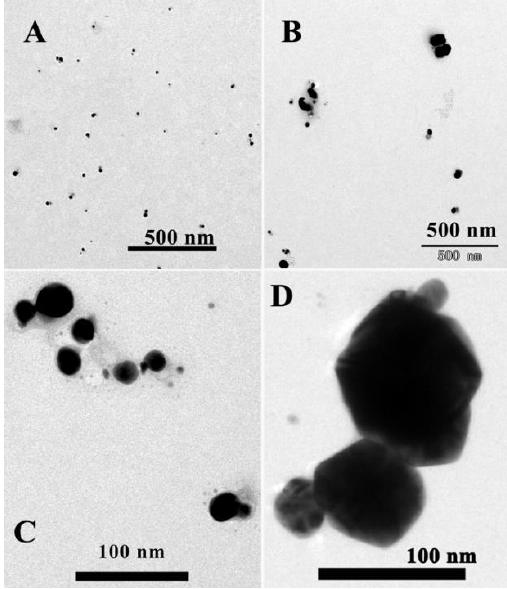
Figure 1. TEM images of Ag-TPA CPNs in the absence ( A , C ) and presence ( B , D ) of ALP.